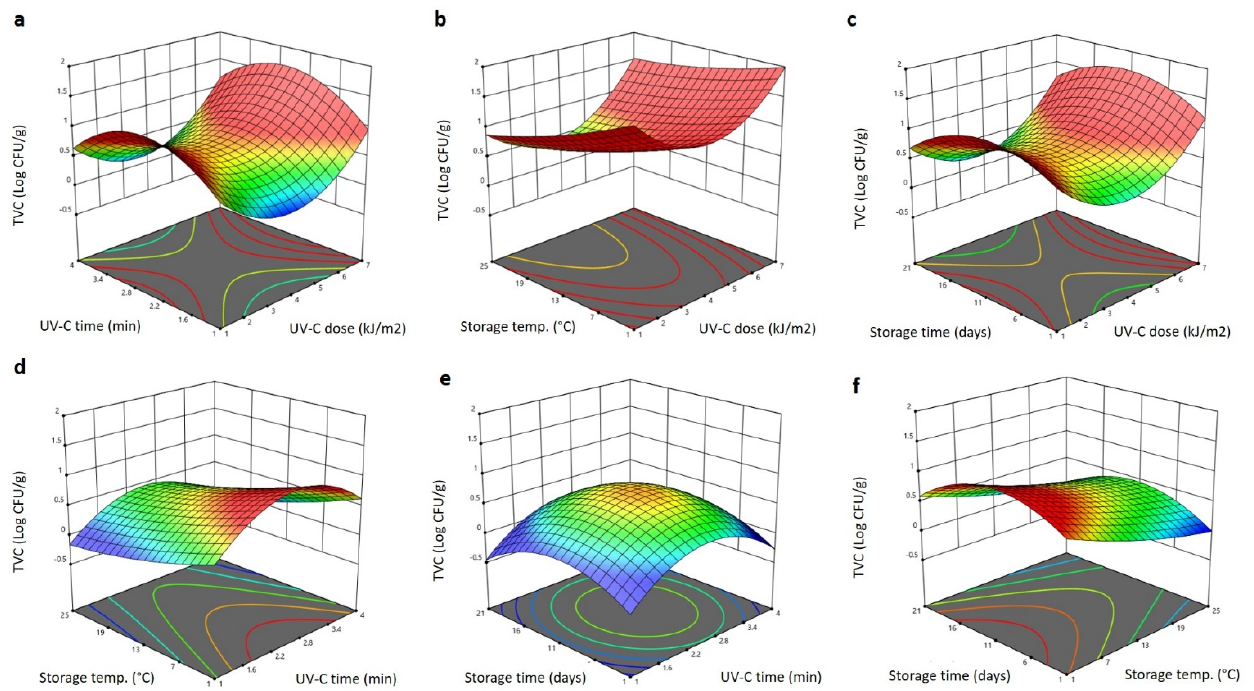
Figure 5. Response surface plots of total viable count (TVC) of Barhi dates as a function of UV-C time and UV-C dose ( a ), storage temperature and UV-C dose ( b ), storage time and UV-C dose ( c ), storage temperature and UV-C time ( d ), storage time and UV-C time ( e ), and storage time and storage temperature ( f ).